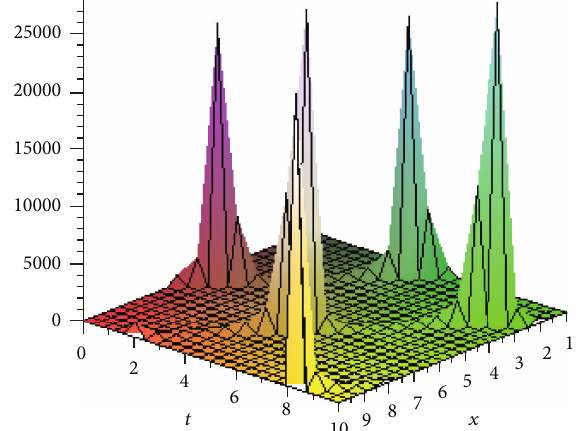
Figure 4: The solution 𝑈 4 in (35) with 𝛾 = 4/5 , 𝑘 = 𝑐 = 𝜎 = 𝑏 2 = 1 , = 0 . 𝜇 = 1 , 𝜉 0